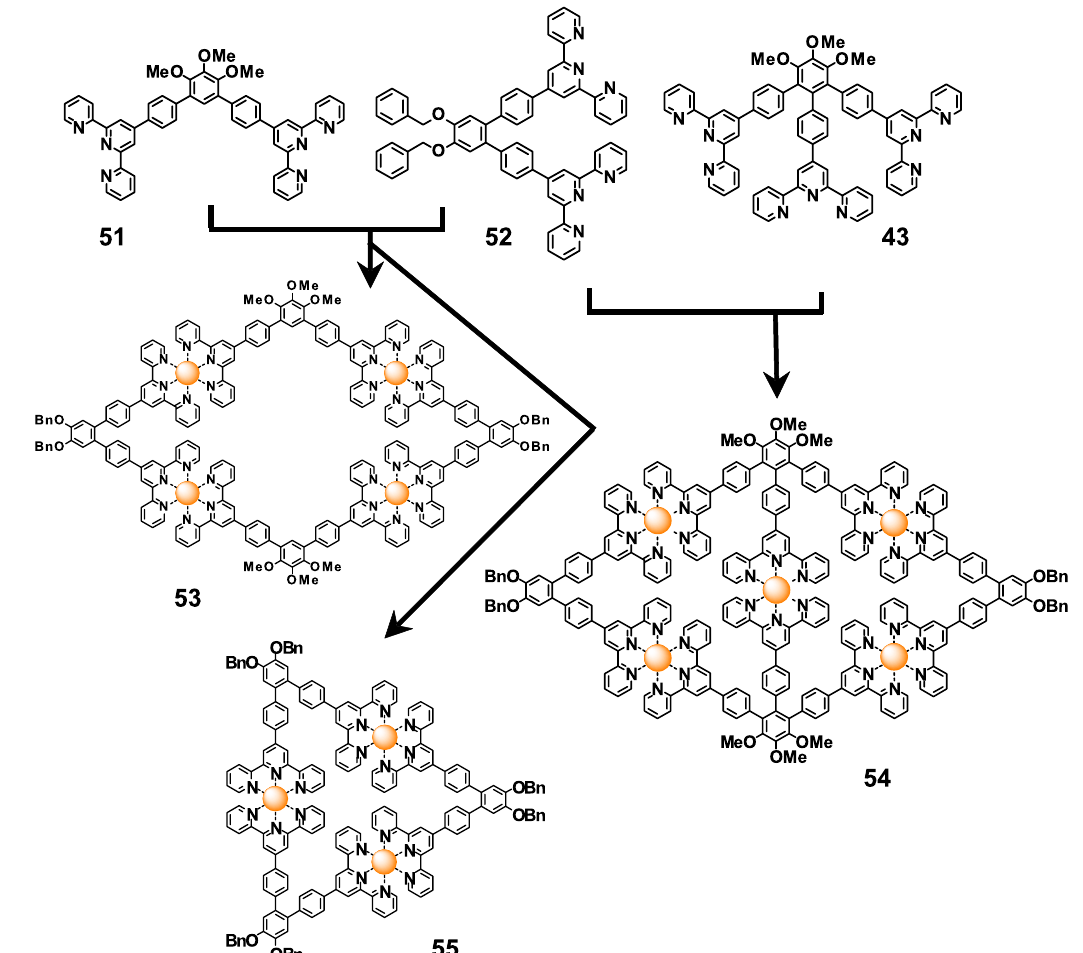
FIGURE 22 – Preparation of rhombohedral structures [Lu, X.; Li, X.; Wang, J.-L.; Moorefield, C. N.; Wesdemiotis, C.; Newkome, G. R. Chem. Commun. , v.48, p.9873-9875, 2012. – Reproduced by permission of The Royal Society of